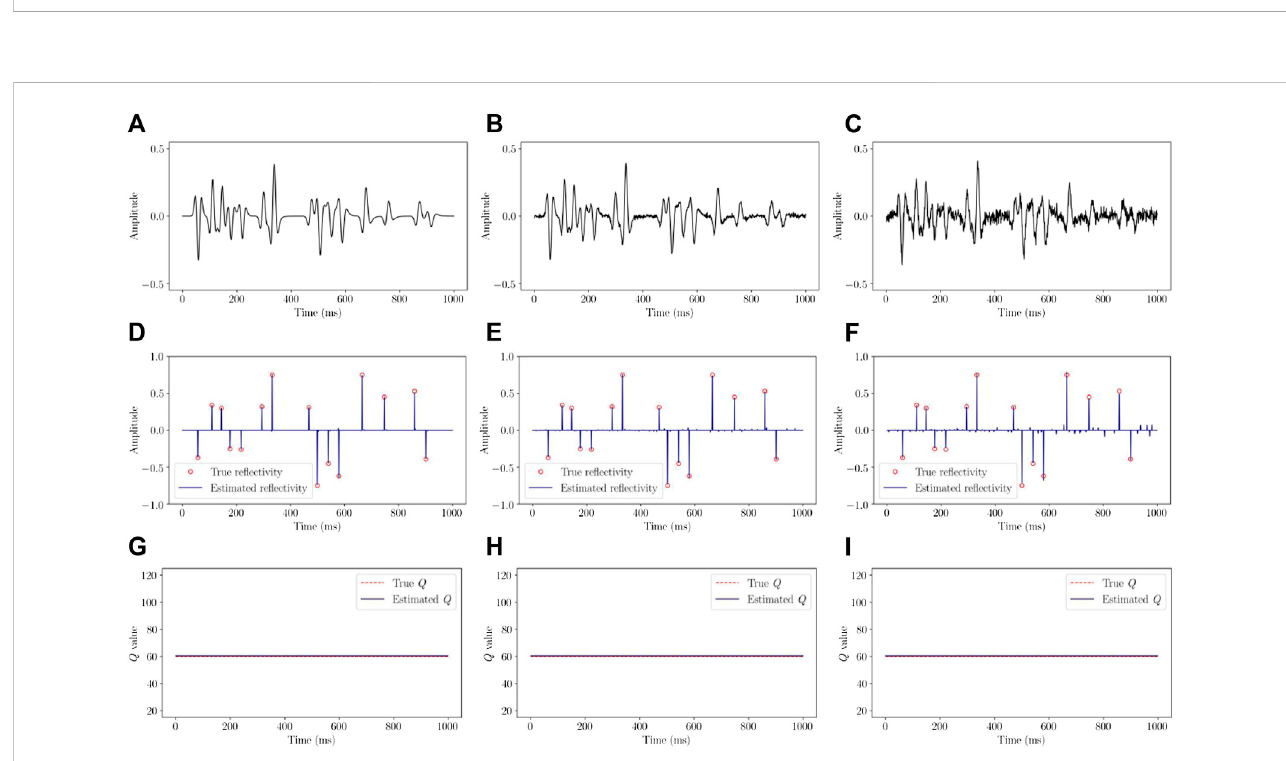
FIGURE 4 Complex synthetic traces attenuated by using constant- Q model ( Q = 60) and contaminated by random noises of different levels: (A) 0.1%, (B) 5%, and (C) 10%. The estimated re fl ectivity series are shown in (D – F) . The true non-zero re fl ectivity coef fi cients are shown by the red points. The corresponding estimations of the Q values are showed in (G – I) . The true Q values are shown in red